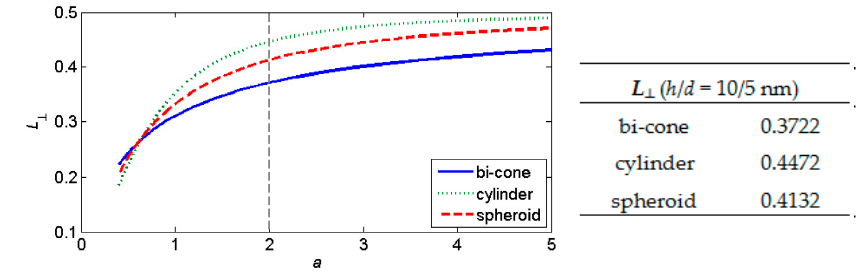
Figure 5. Depolarizing factor L ⊥ dependence on the parameter a .